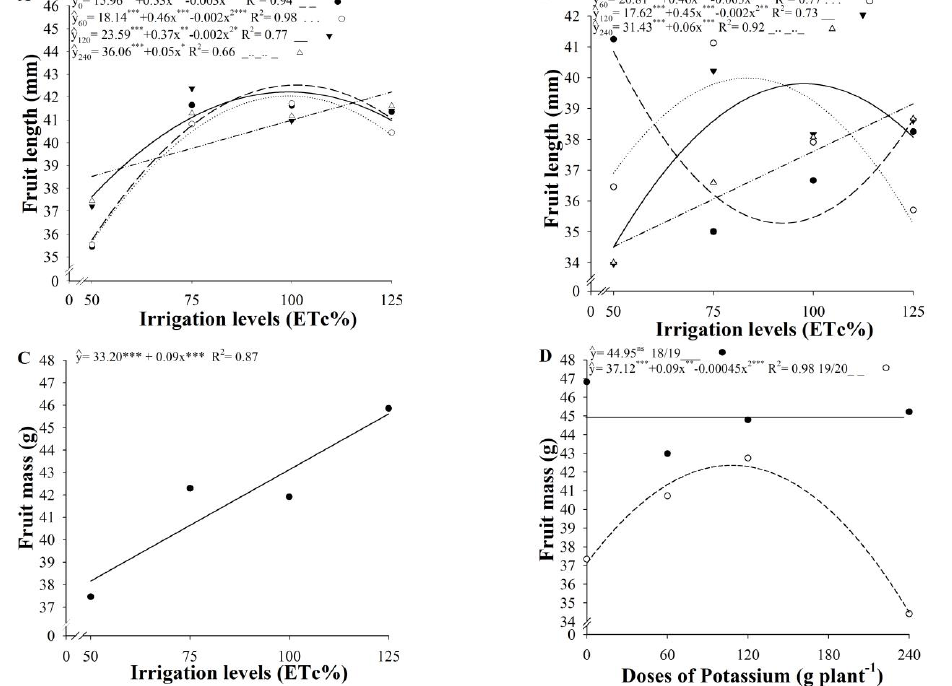
Figure 5. Fruit length (( A ) — 18/19 and ( B ) — 19/20) and average fruit mass as a function of irrigation levels — Li ( C ) and potassium doses ( D ) in fig plants grown under semiarid climatic conditions in the 2018/2019 and 2019/2020 crop years. ns Not significant ( p > 0.05); * Significant ( p < 0.05); ** ( p < 0.01); *** ( p <